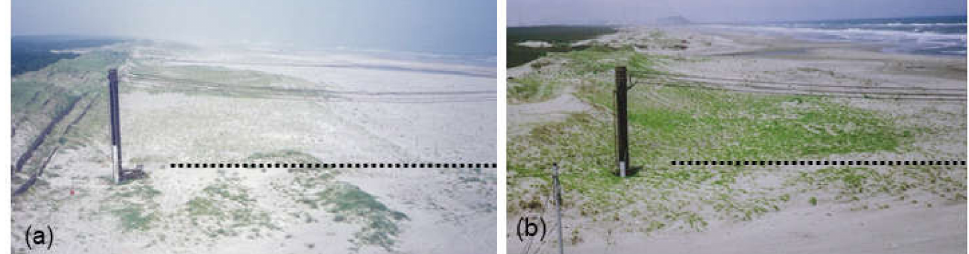
Figure 13. Photos of vegetation along and around the survey line taken on 2 August 1995 ( a ) and 1 June 2007 ( b ). The broken lines display the survey